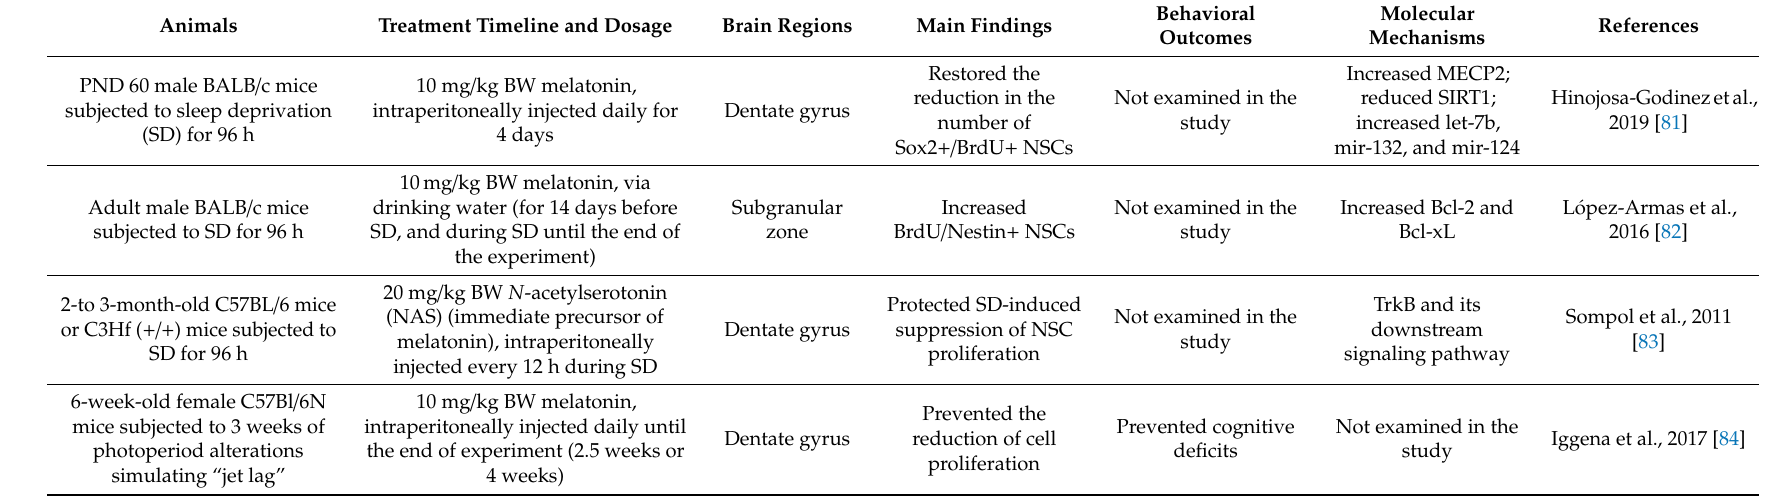
Table 8. Table showing the main findings regarding the e ff ects of melatonin or its precursor on neurogenesis in sleep deprivation and “jet lag” and the respective molecular mechanisms in the in vivo